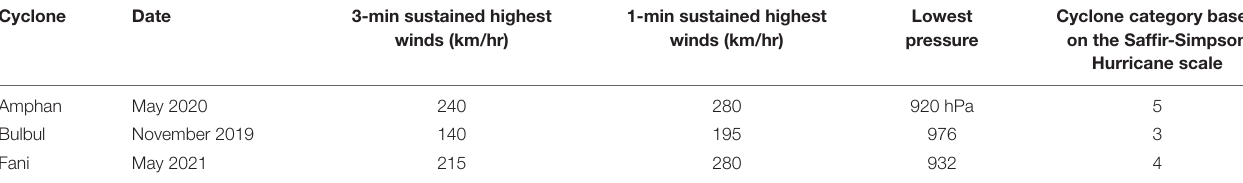
TABLE 1 | Cyclone characteristics based on maximum values for the entire life of the cyclone.